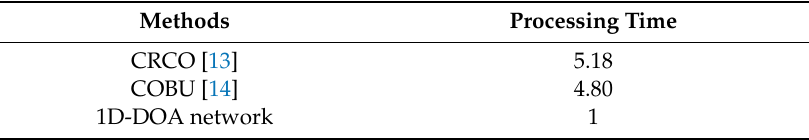
Table 4. Comparison of methods in processing